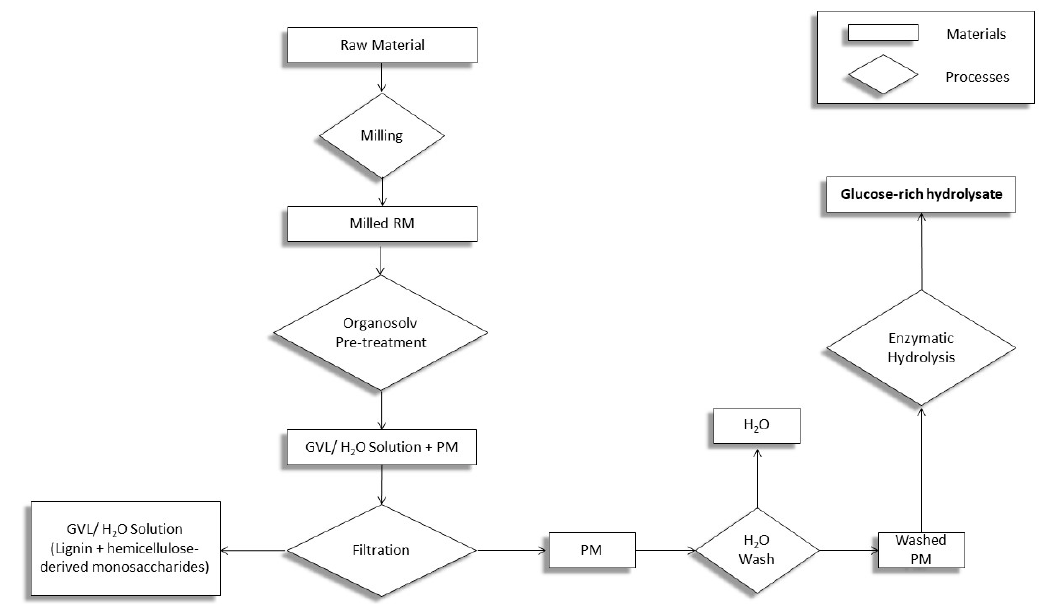
Figure 1. Flowchart of the overall process for the production of fermentable glucose.